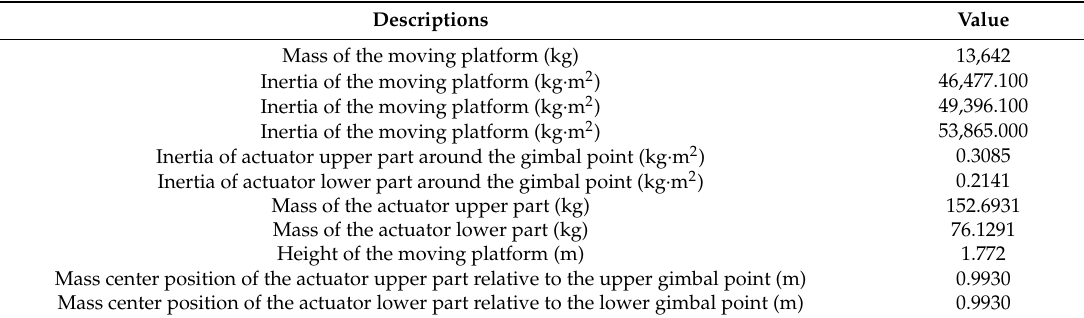
Table 2. Nominal dynamic parameters of the Simulink ® model.